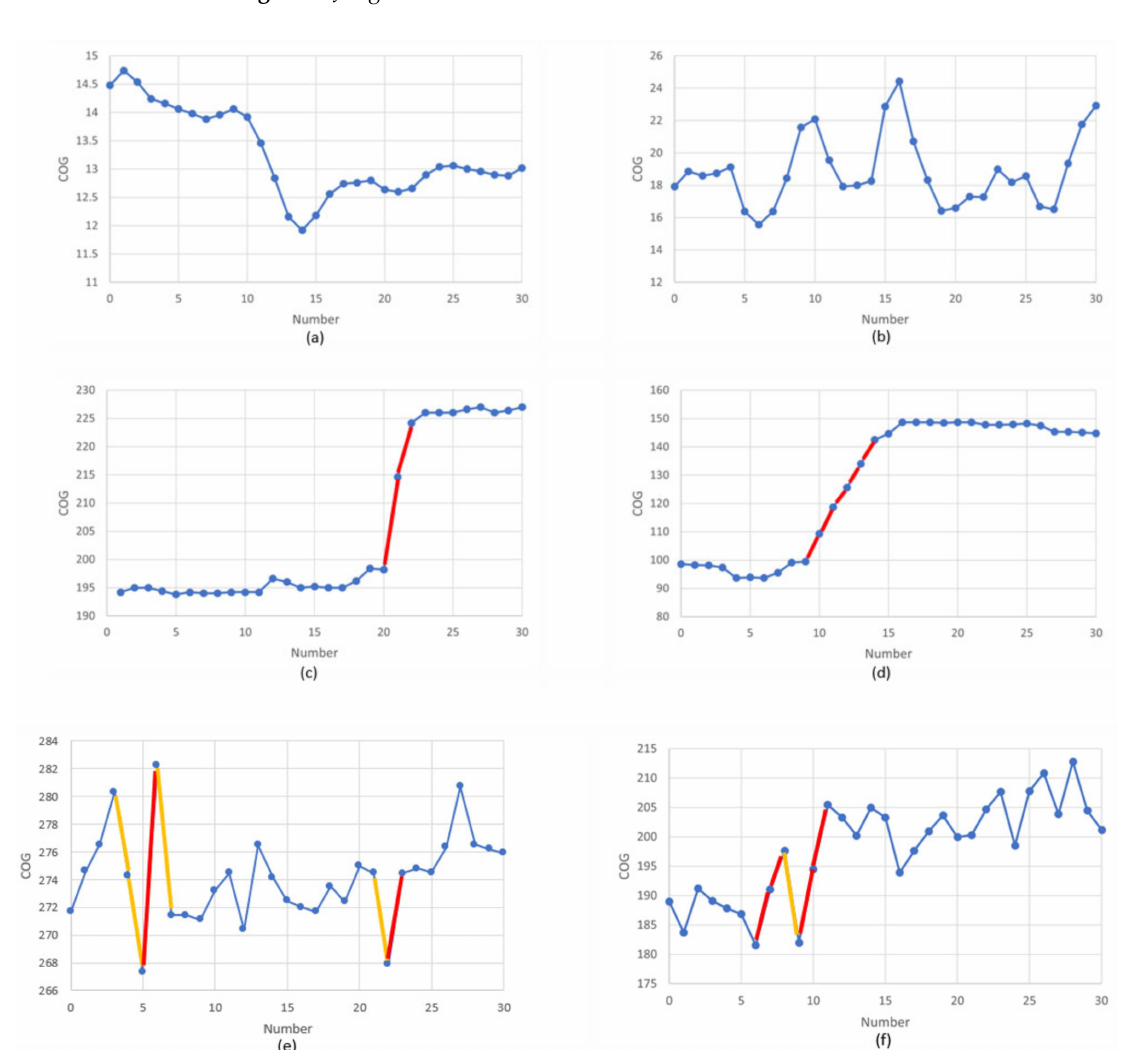
Figure 4. The COG transforms of vessel ( a ) 411747900; ( b ) 215280000; ( c ) 477118100; ( d ) 413484000; ( e ) 413697130; ( f ) 413705580. Red line, left turn; Yellow line, right